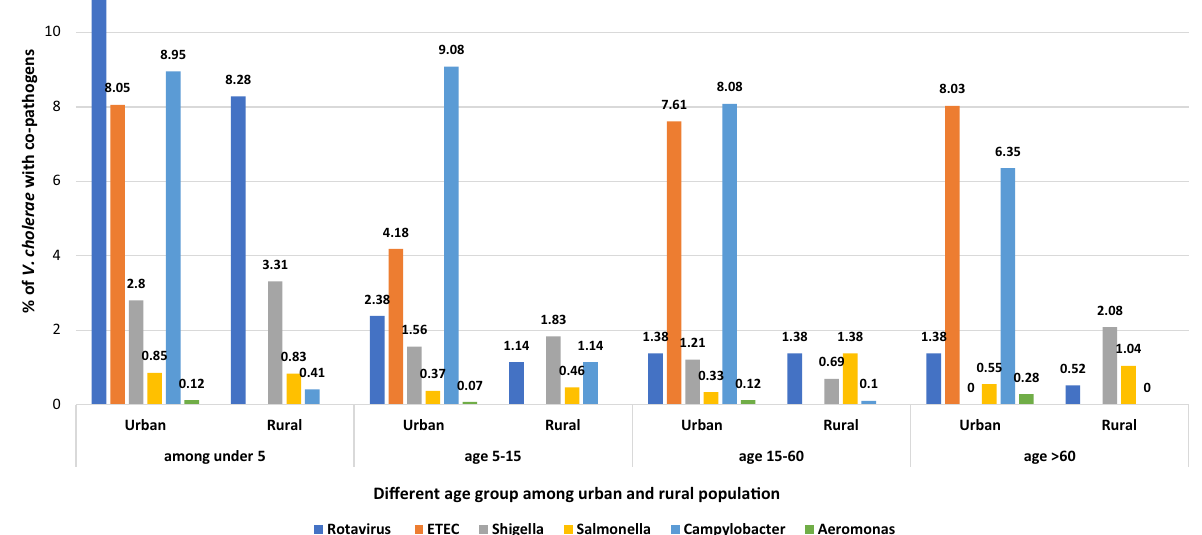
Figure 2. Co-pathogens isolated among V. cholerae positive patients admitted during 2000–2021.